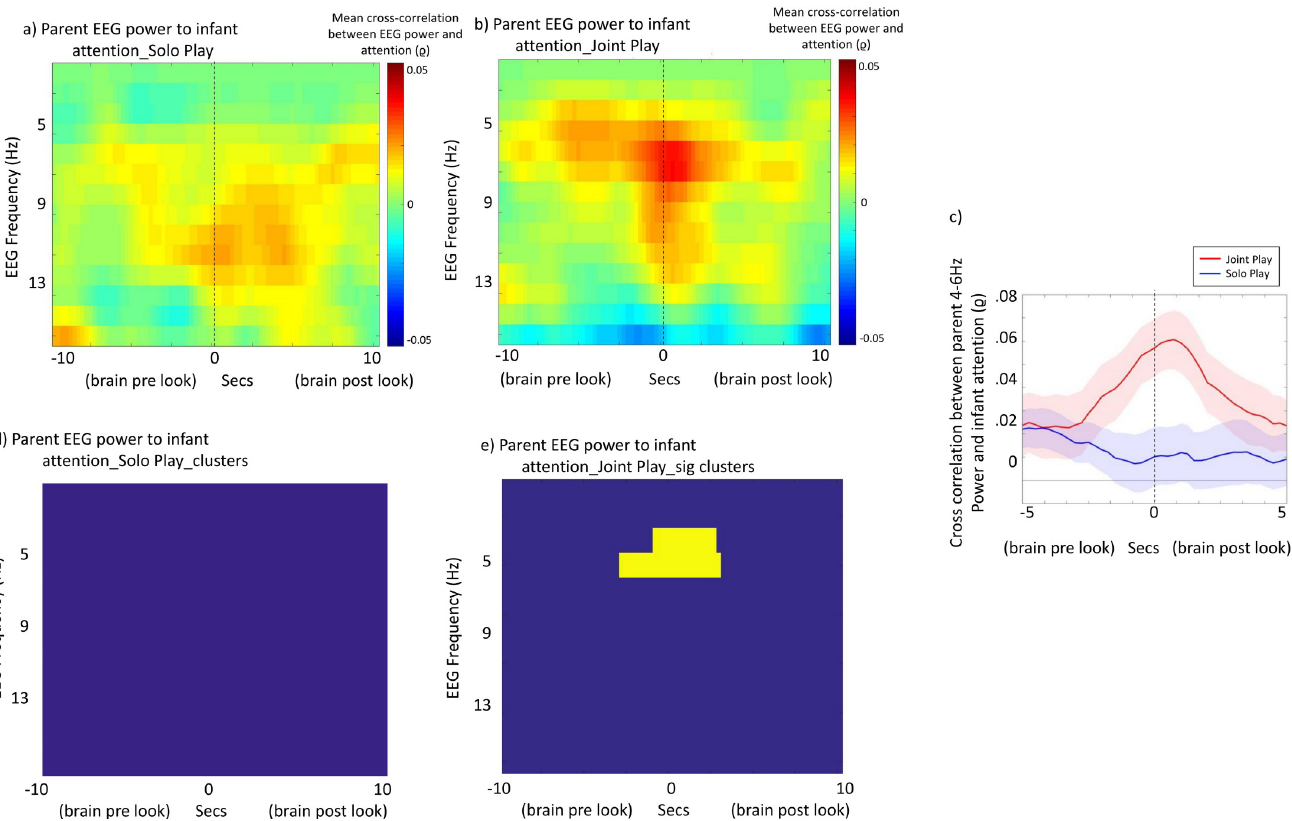
Fig 5. Brain–behaviour associations: Adult brain and infant behaviour. (a and b) Mean time-lagged cross-correlations between parent EEG power and infant attention for (a) solo play and (b) joint play. Time lag between brain activity and visual attention is shown on the x-axis, and the EEG frequency on the y-axis. (c) Line plot showing cross-correlation between EEG power and visual attention for just the frequency ranges identified from the cluster-based permutation test as showing marked differences in the joint play condition (4 Hz–6 Hz). Red shows the joint play condition, and blue the solo play condition. Shaded areas show interparticipant variance (standard errors). (d and e) Results of the cluster-based permutation statistic. Yellow squares indicate time × frequency points of significant cross-correlations. The underlying data for this figure can be found in S1 Text and S1